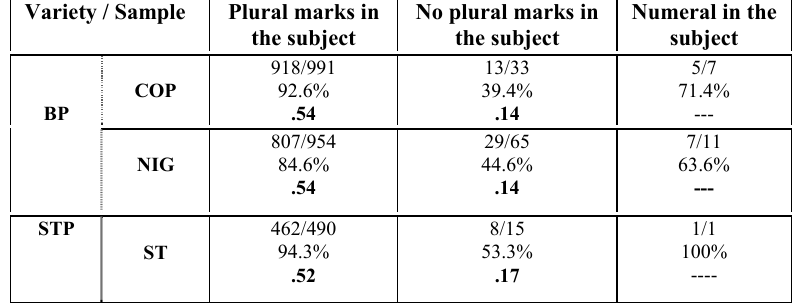
Table XVIII: Third person plural verbal marking and Clausal parallelism by variety of Portuguese Variety / Sample Plural marks in Numeral in the